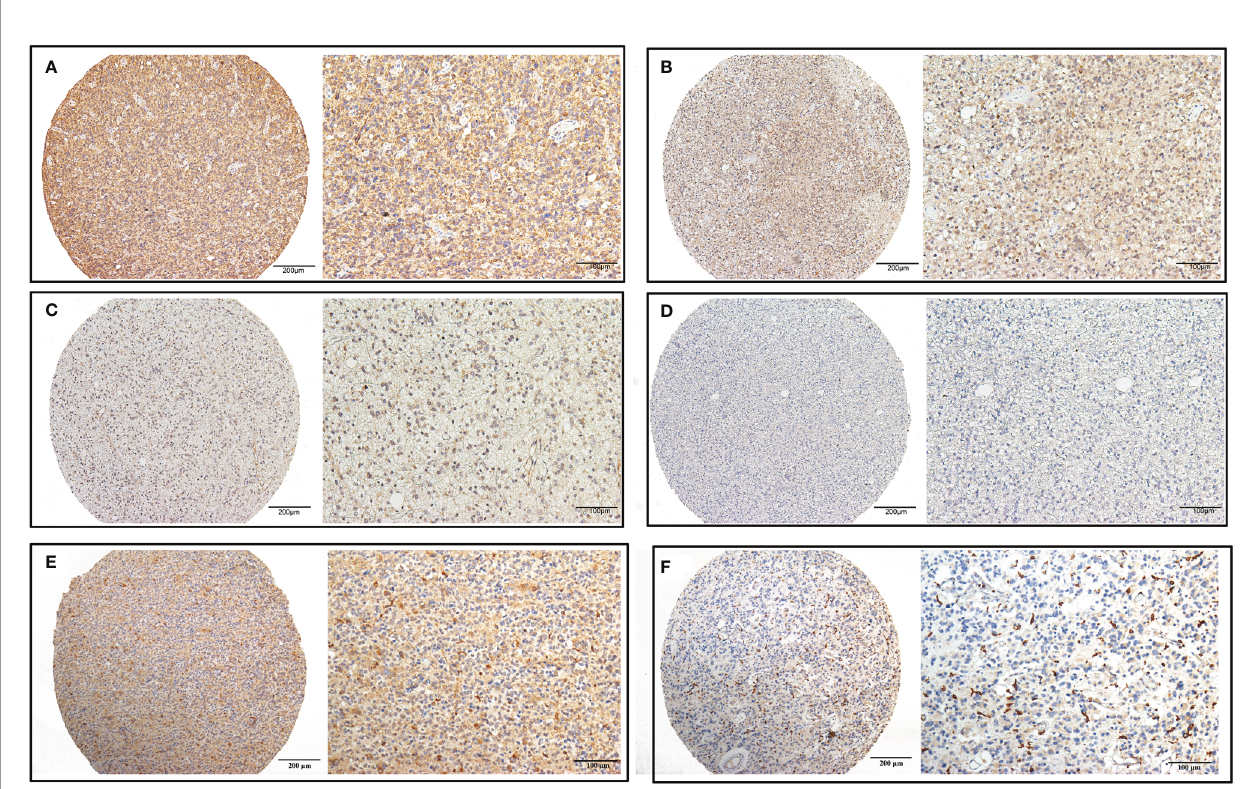
FIGURE 1 | CHI3L2 protein expression was detected by IHC. Representative images of strong (A) , moderate (B) , weak (C) , and negative (D) staining of CHI3L2 are shown. Representative images of the high density of CHI3L2+ macrophages in strong (E) and weak (F) staining glioma tissues are